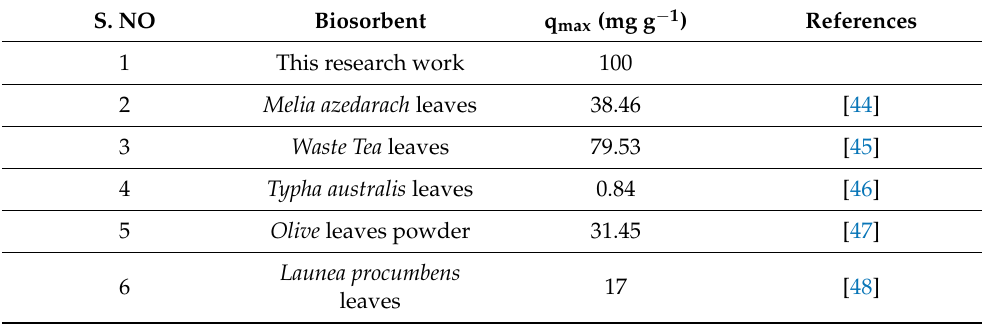
Table 5. Comparison of present adsorbent capacity with those reported in